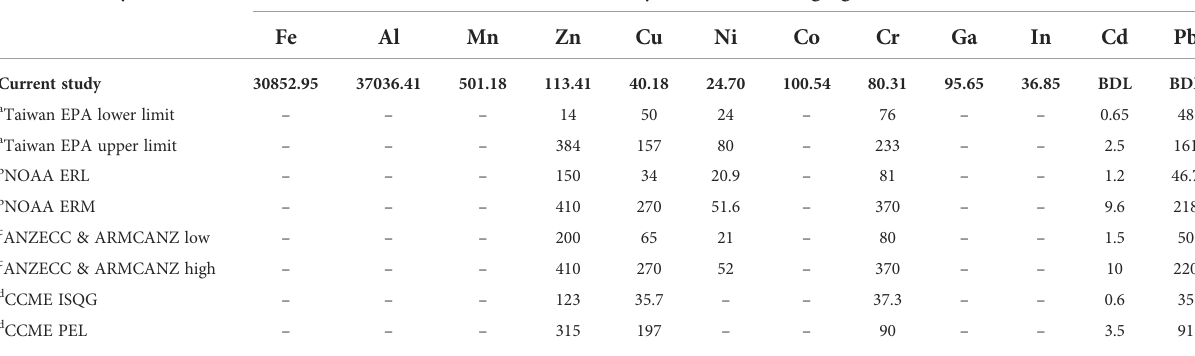
TABLE 2 Comparison among the overall average of heavy metal concentrations in the Siangshan wetlands ’ sediments (current study) and sediment quality guidelines (SQGs) worldwide. Current study &